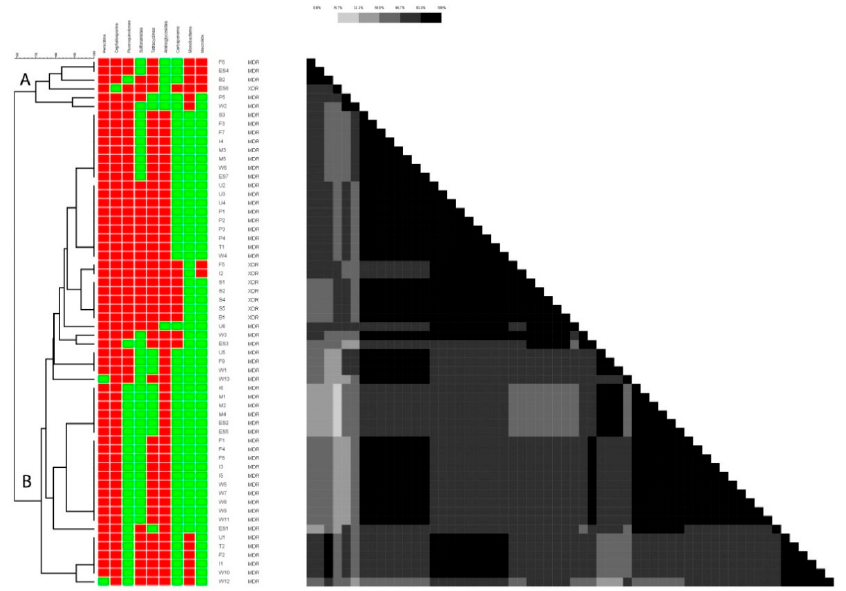
Figure 1. Overall clustering of E. coli strains from humans, animals, and the environment is showing similarities across different origins. The red color is representing resistance while the green color is indicative of susceptibility to the antibiotic mentioned in the same lane. Different pathotypes of E. coli were identified based on virulence genes and their combinations. The strains carrying stx 1 and/or stx 2 genes are declared as STEC, the strains bearing eaeA gene are considered EPEC, the strains harboring the hlyA gene are declared as EHEC and the strains showing combinations of these virulence genes were typed accordingly. There were only 5/60 strains that carry eaeA gene alone and were de- clared as EPEC and the 1/60 strain was identified as EHEC as it harbored the hlyA gene, whereas all other strains were found to harbor more than one virulence gene (Table 2). Most of the strains were detected to have the combinations of stx , eaeA , and hlyA genes and considered STEC/EPEC/EHEC. Moreover, 2/60 strains were identified as EPEC/EHEC, 2/60 as STEC/EHEC, and one as STEC/EPEC (Figure S2). The difference in the distribution of these pathotypes among the three ecologies is found statistically sig- nificant with a p -value of 0.019. It is noticeable that human origin E. coli strains are showing all the mentioned pathotypes while animal and environmental origin strains are showing only two of the pathotypes. All the uropathogenic strains and strains recovered from cattle feces, cattle milk, and soil were found to belong to pathotype STEC/EPEC/EHEC which shows the firm interaction of all these ecologies (Figure S3). Moreover, it is observable that there are 18 strains of animal and environmental origin each (total of 36) and 13 human origin strains that carry the combination of all the studied genes ( stx , eaeA , and hlyA ) indicating the abundance of these genes as well as greater opportunities of transferring the genes between the strains in different niches.